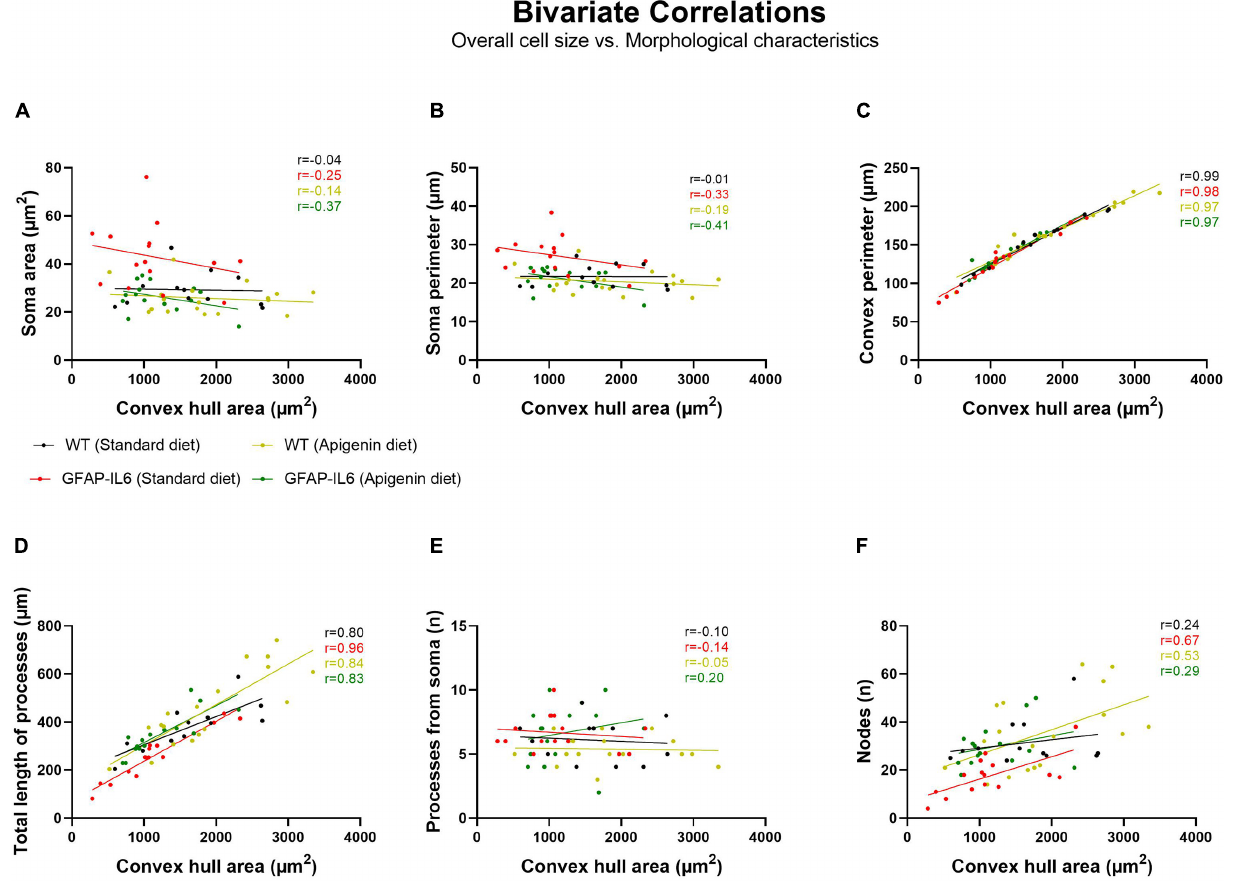
FIGURE 7 | Bivariate correlations between overall microglial cell size and morphological characteristics in the hippocampus. Morphological parameters have been plotted against the convex hull area ( µ m 2 ), including (A) soma area, (B) soma perimeter, (C) convex perimeter, (D) process length, (E) number of processes from soma, and (F) node number. TABLE 1 | Bivariate correlation of different morphological parameters with overall microglial cell size in the hippocampus. Soma area Soma perimeter Convex Total length of Processes processes ( µ m) from soma